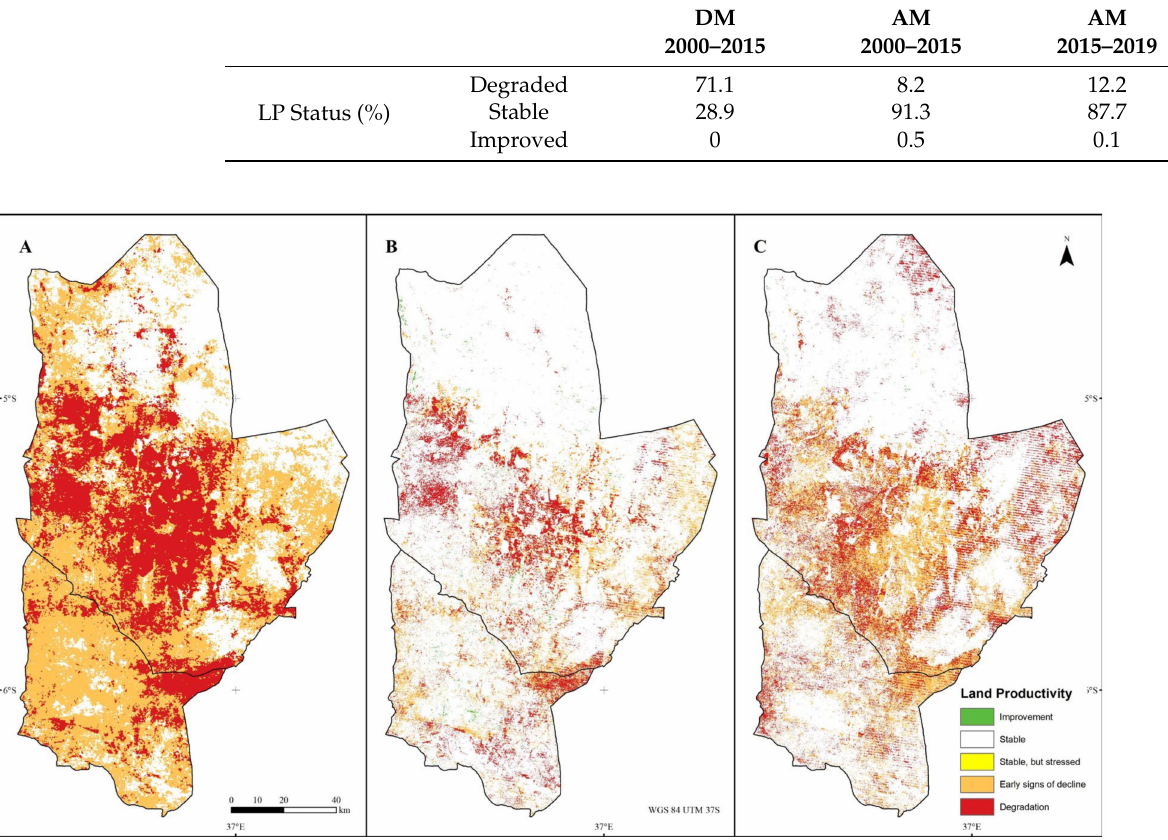
Figure 4. The land productivity sub-indicator generated using ( A ) the default approach with MODIS imagery, ( B ) the adapted approach with Landsat imagery for the baseline period, and ( C ) the adapted approach with Landsat imagery for the monitoring period